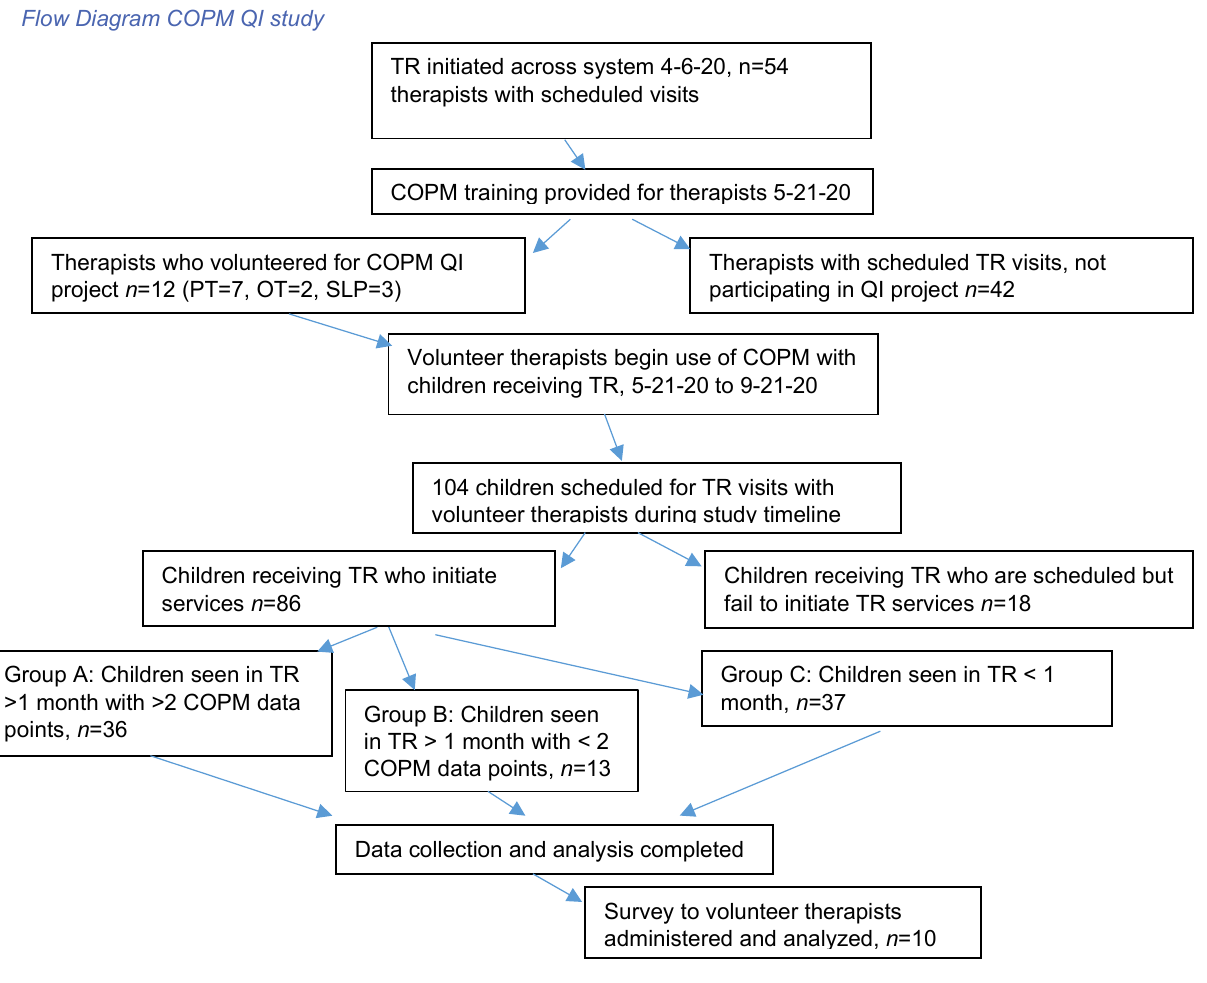
Flow Diagram COPM QI study